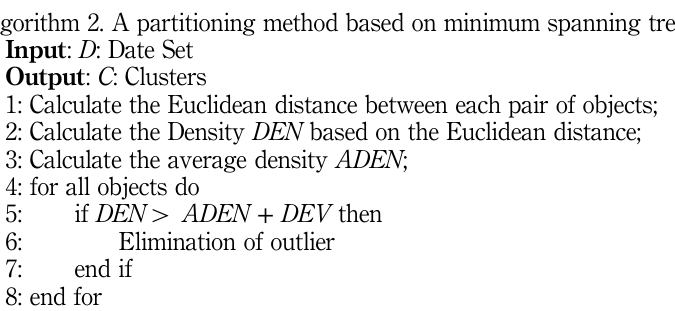
Algorithm 2. A partitioning method based on minimum spanning tree.